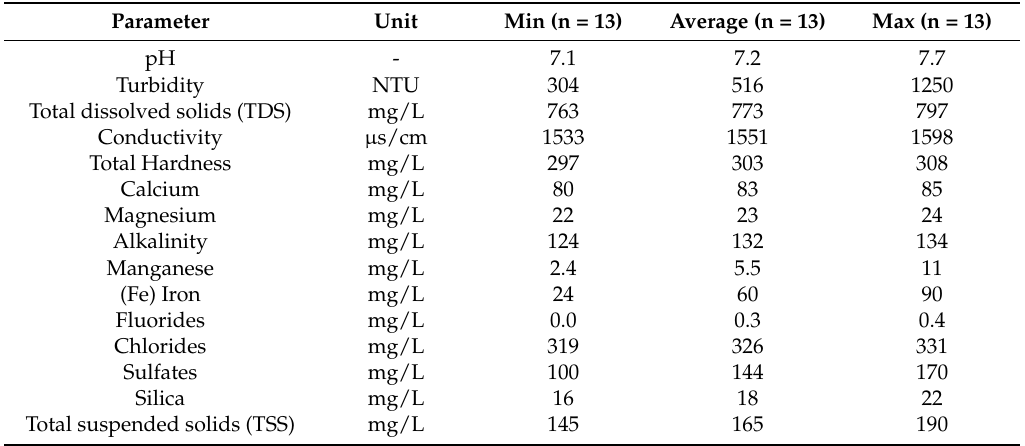
Table 3. Sand filter backwash water (SFBW) quality of the Buraidah water treatment plant.